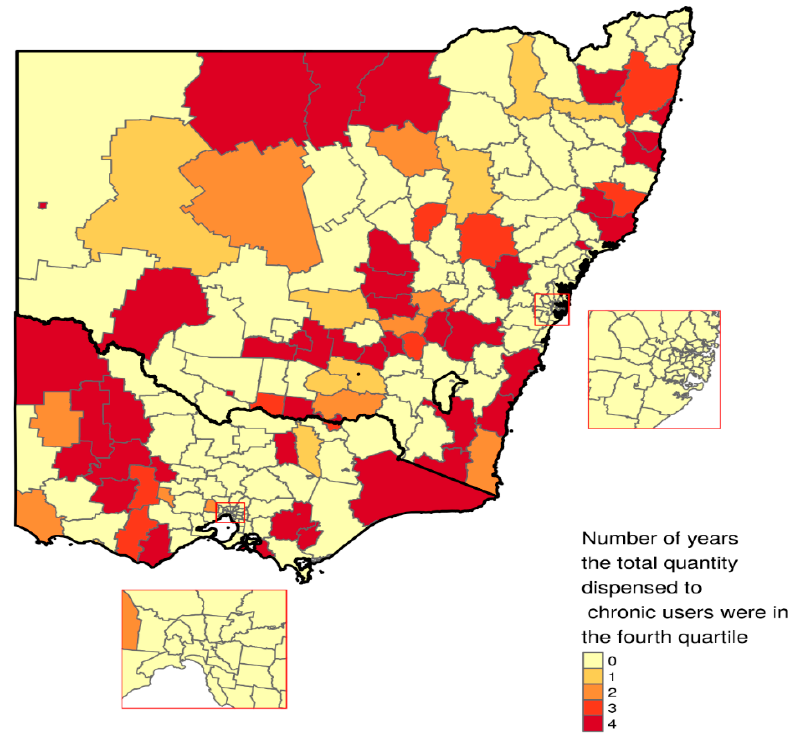
Figure 3. LGAs in New South Wales and Victoria where the total quantity dispensed for the overall population were high (in fourth quartile) in different years (unit: DDD/1000 people/day adjusted for age and sex).